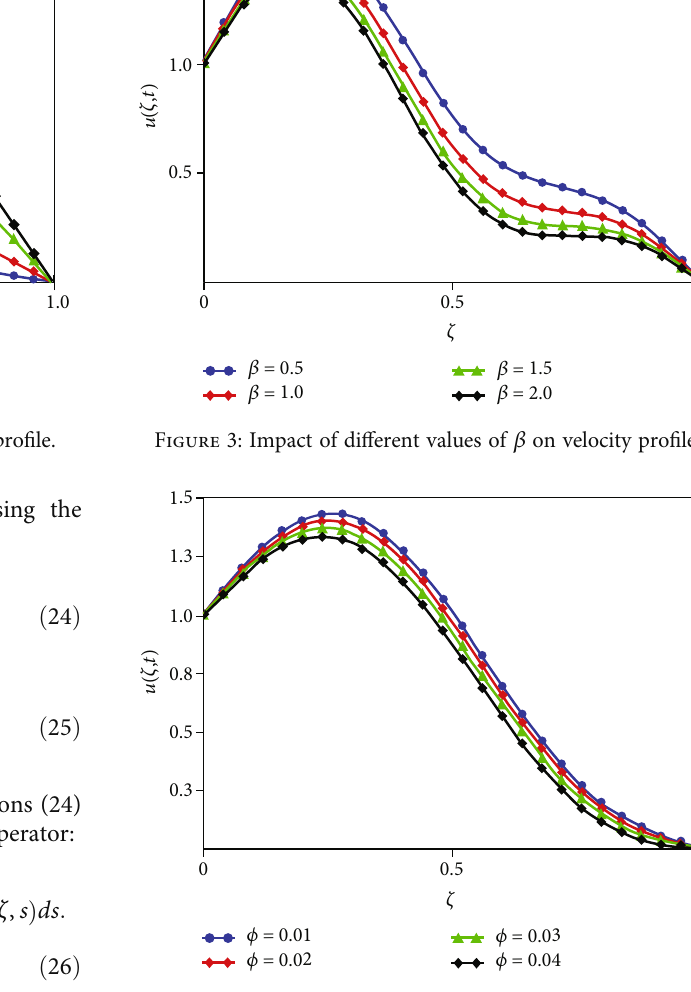
Figure 4: Impact of di ff erent values of ϕ on velocity pro fi